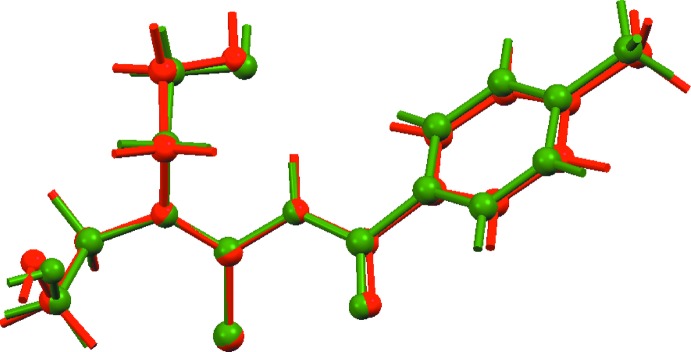
Overlay diagram for experimental (green image) and geometry-optimized (red) mol­ecules for (I). The mol­ecules have been overlapped so the S=C—N—C=O fragments are coincident.